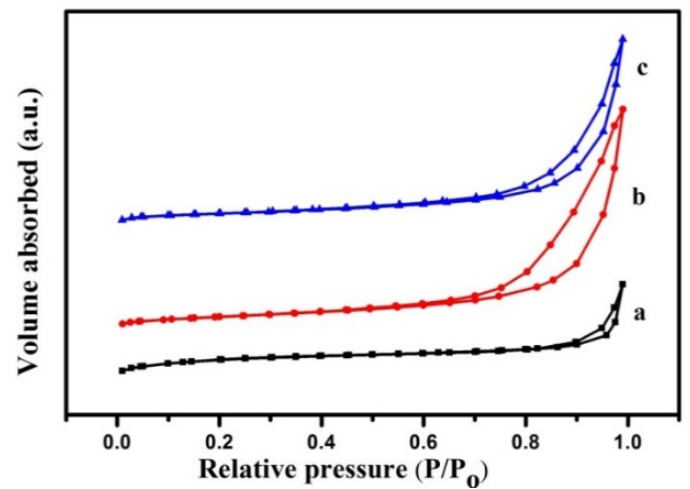
Figure 9. Low-temperature N 2 adsorption–desorption isotherms of PtSn/Mg(Al)O with different Mg:Al ratios: ( a ) Mg:Al = 2:1; ( b ) Mg:Al = 5:1; ( c ) Mg:Al = 10:1. Table 2. Textural properties of PtSn/Mg(Al)O catalysts with Mg:Al ratios of 2:1 (Mg(Al)O ‐ 2), 5:1